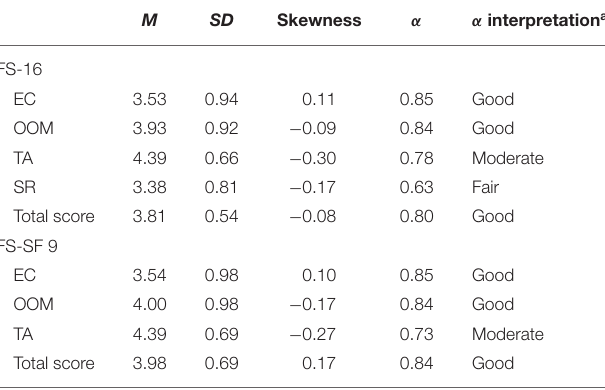
TABLE 4 | Descriptive comparisons of FS-16 and FS-SF